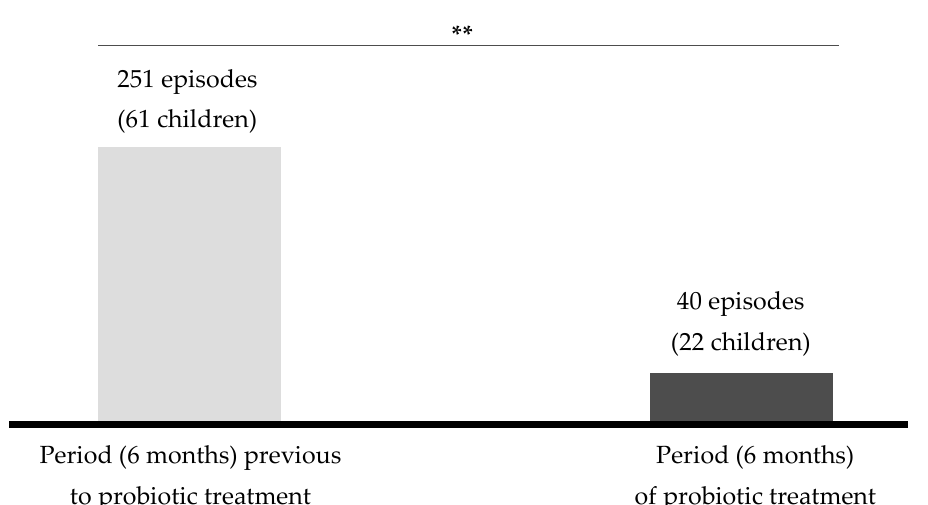
Figure 2. Comparison between the number of AOM episodes reported during the 6 months of the probiotic treatment and those reported during the previous 6 months. **, statistically significant change ( p < 0.05; χ 2 test).